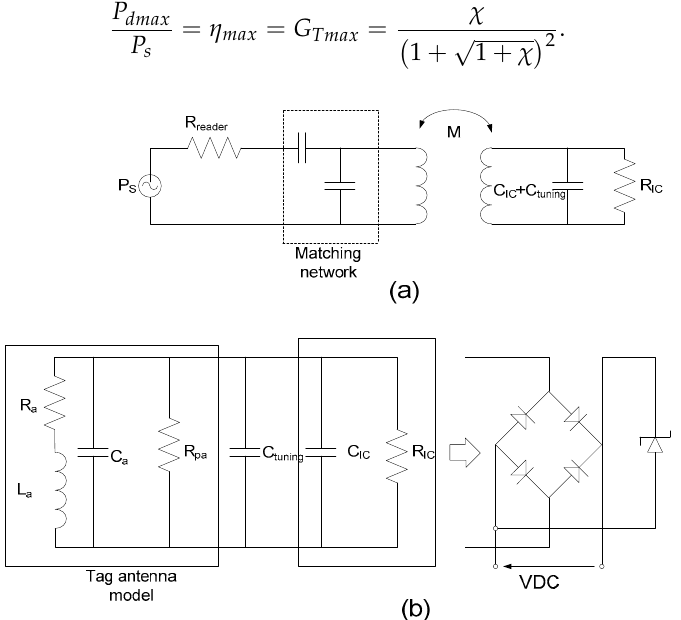
Figure 3. ( a ) Two-port transfer model between reader and tag; ( b ) tag model.